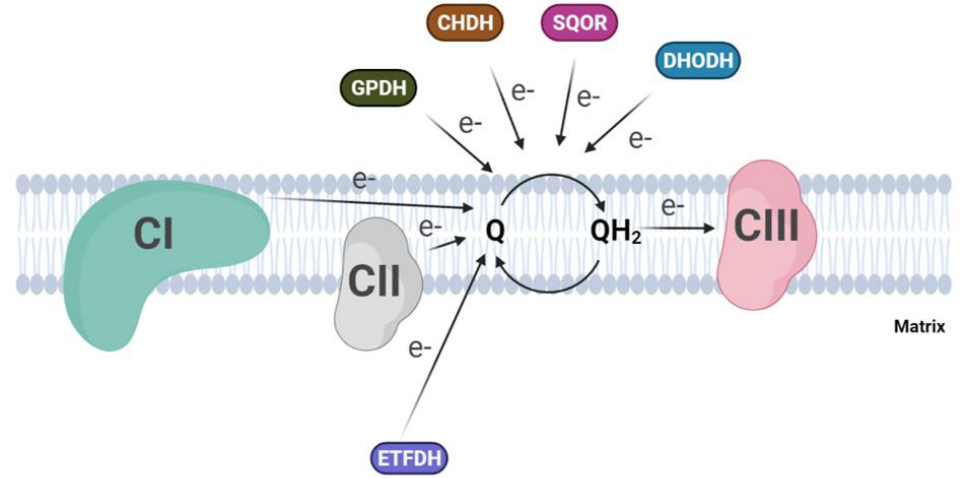
Figure 2. Convergent electron flow to the Coenzyme Q pool in the inner mitochondrial membrane. (CI, Complex I; CII, Complex II; CIII, Complex III; GPDH, Glycerol-3-phosphate dehydrogenase; CHDH, choline dehydrogenase; SQOR, sulphide:quinone oxidoreductase; DHODH dihydroorotate dehydrogenase).